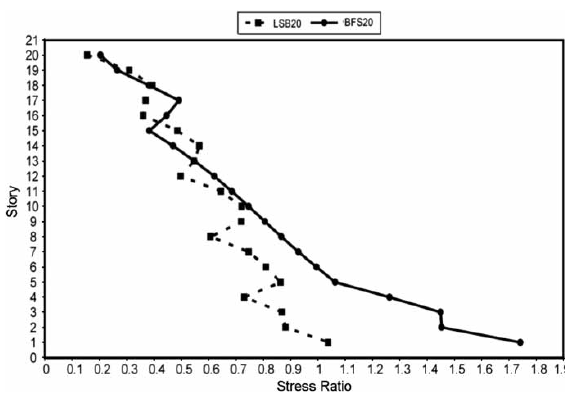
Fig. 23. Summation of the stress ratios in the braces of all models in each